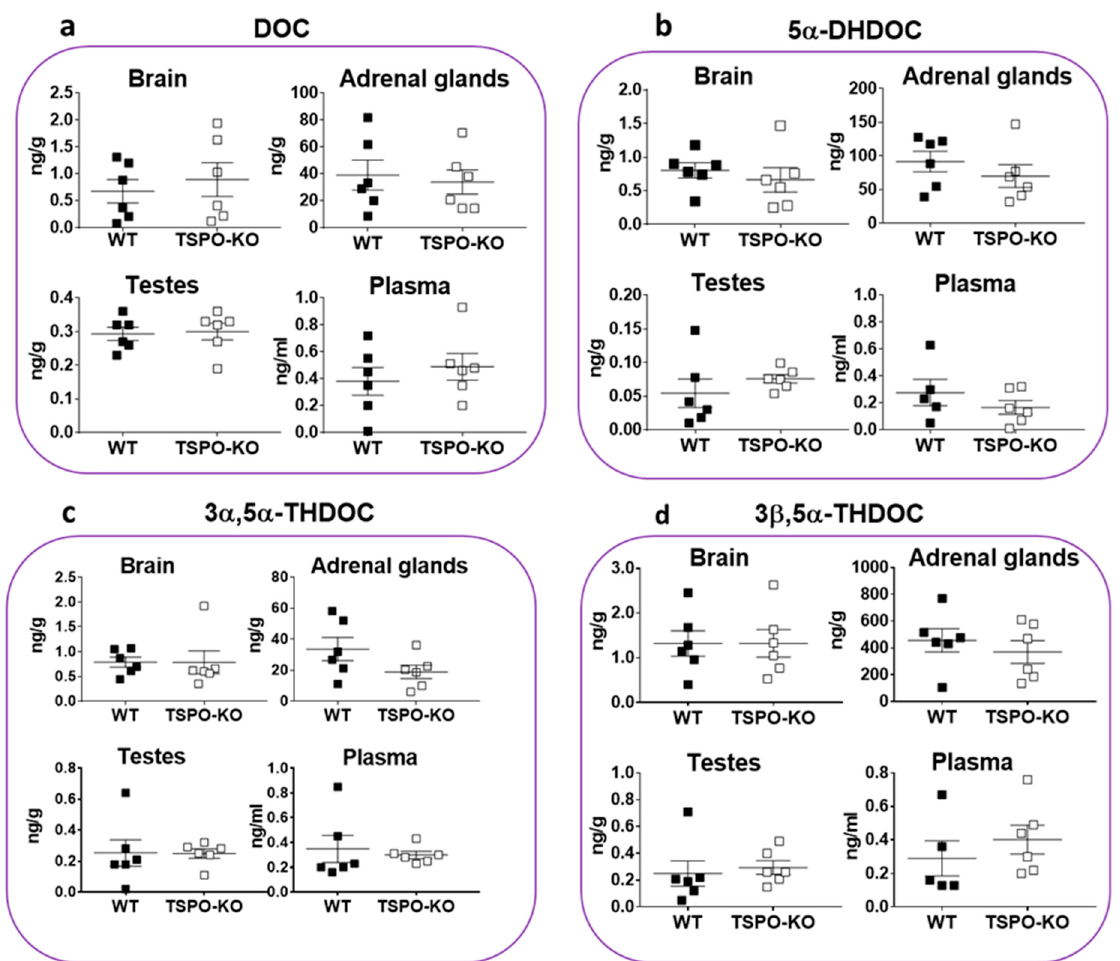
Figure 4. Concentrations of DOC and its 5 α -reduced metabolites in tissues of male WT and TSPO-KO mice analyzed by GC-MS/MS as described in the Material and Methods section. Data are expressed as means ± SEM and were analyzed by unpaired t -test ( n = 5–6).